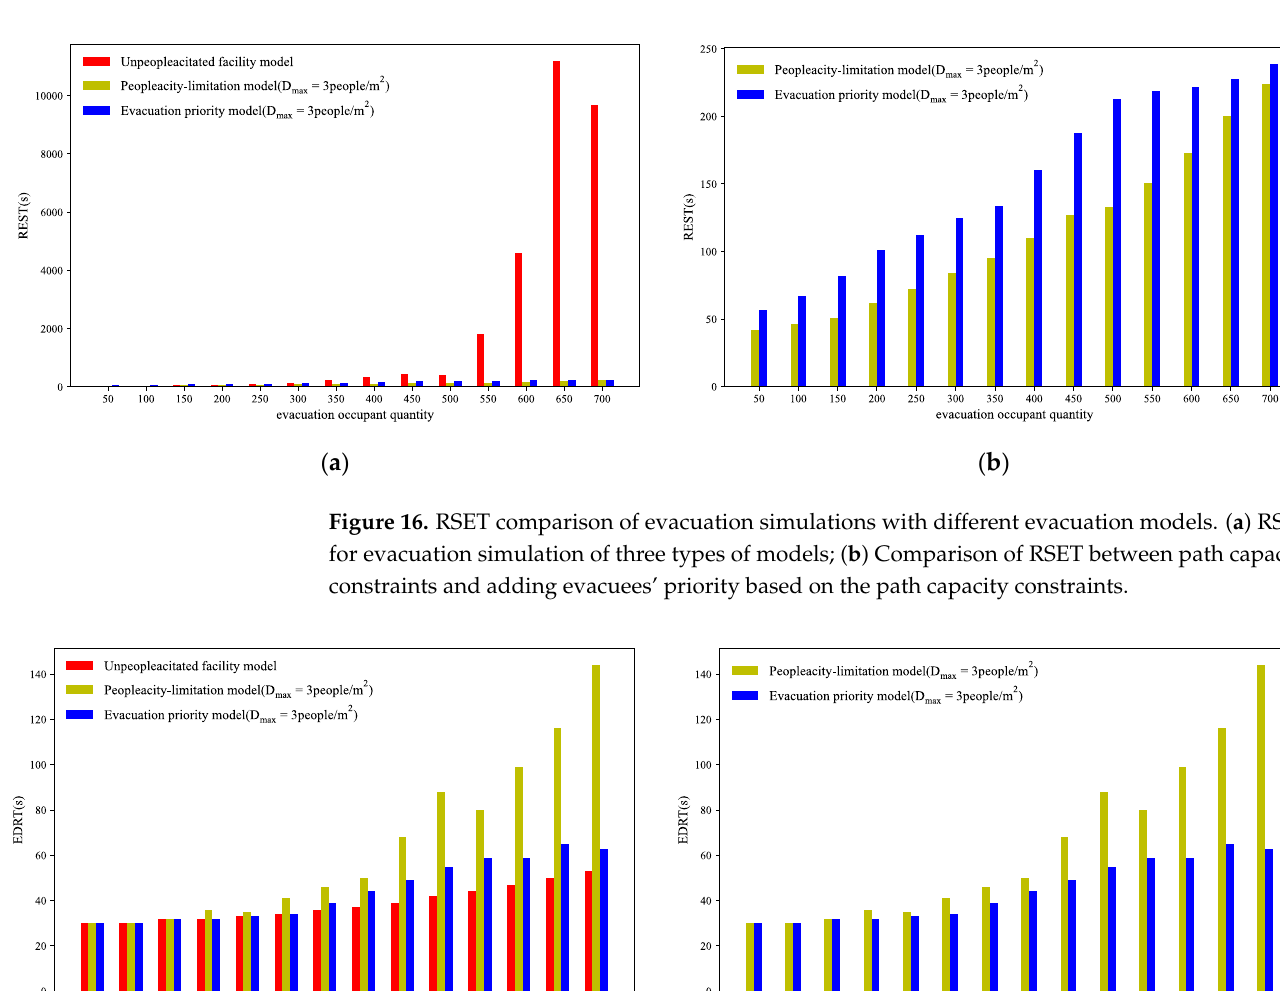
Figure 15. The influence of different ity model. ( a ) The influence polyline of EDRT.